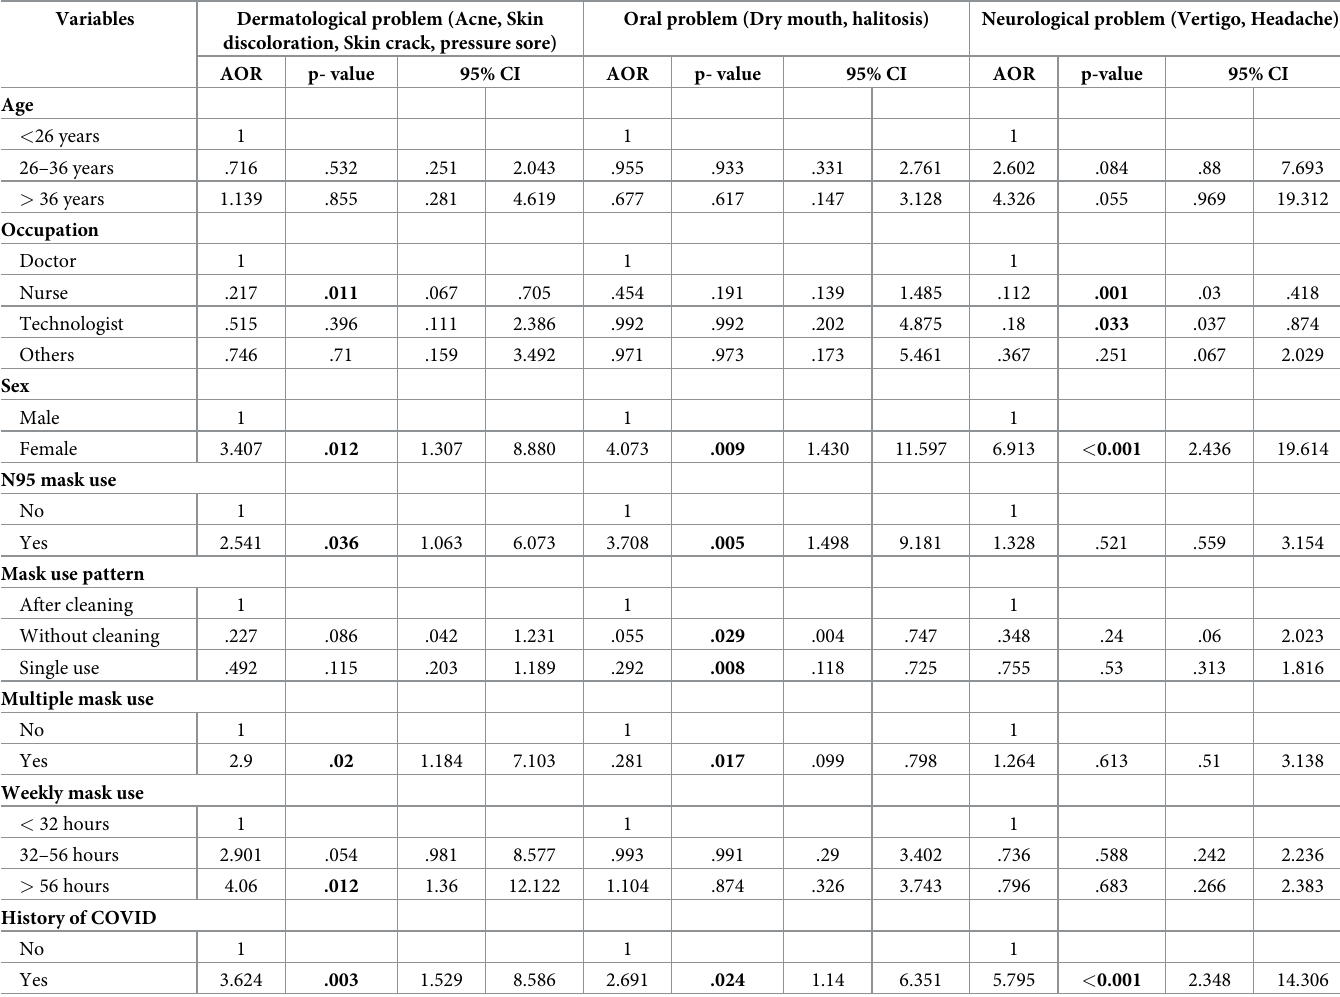
Table 3. Factors associated with dermatological, oral, and neurological problems.